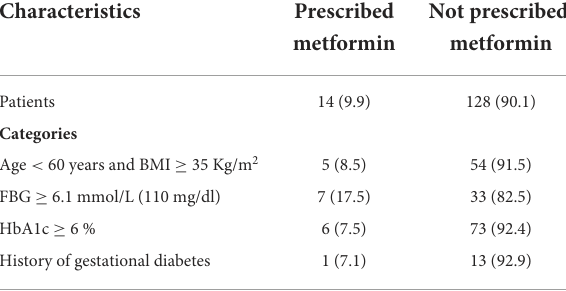
TABLE 5 Sub-analysis for patients who are more likely to benefit from metformin ( n =